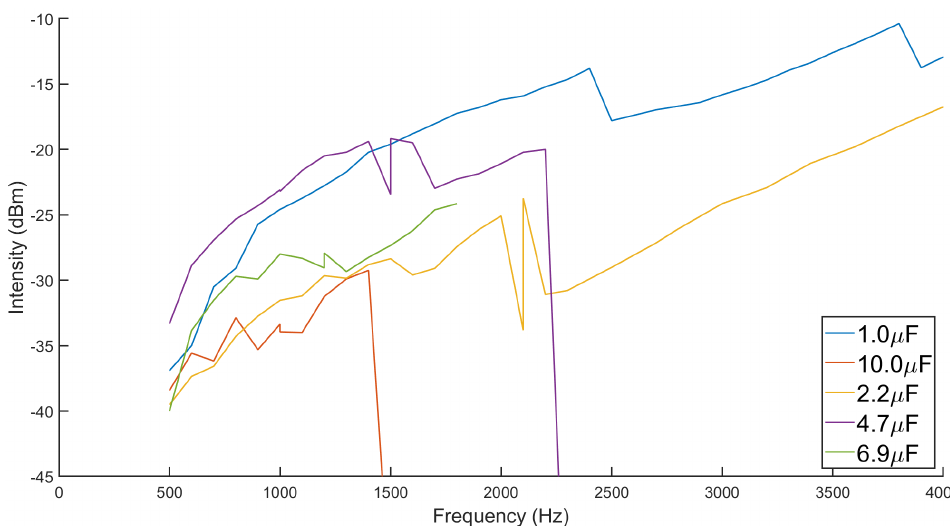
Figure 4. Induction signal amplitude under the same magnetic field versus different excitation frequencies with different tuning capacitances. The intensity power value represents the component of twice the excitation frequency in the induced signal. The intensity of the specific frequency is measured by an Agilent Technologies N9020A MXA Signal